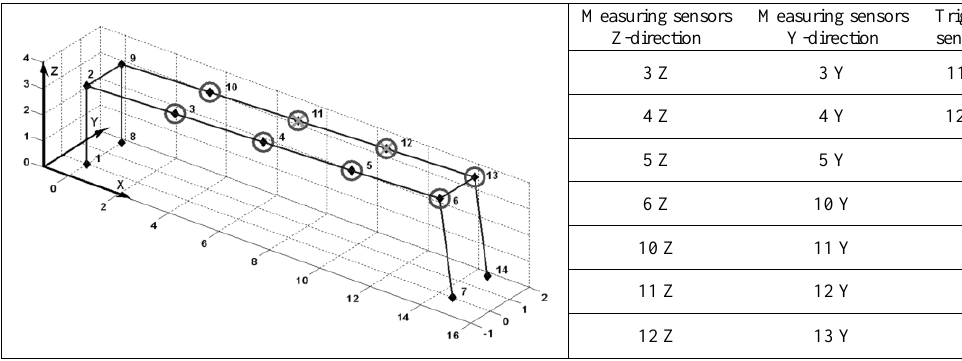
Fig. 3. Candidate (diamonds) −, Triggering (crosses) − and Measuring sensors (circles).